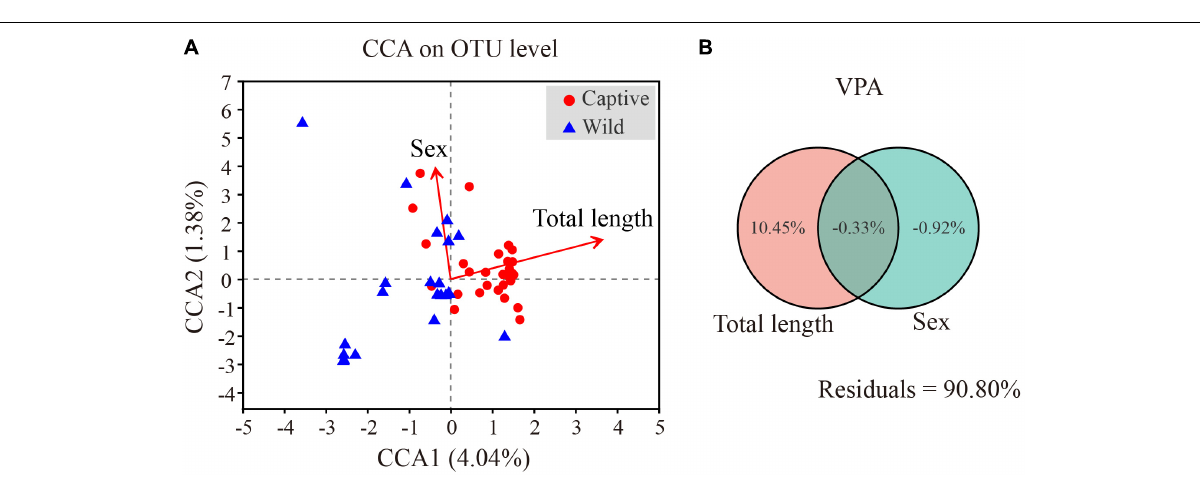
FIGURE 8 | Effects of total length and sex on gut microbiota of Tokay gecko (A) . Canonical correlation analysis of the microbial community on OTU level and physical parameters of Tokay gecko (B)